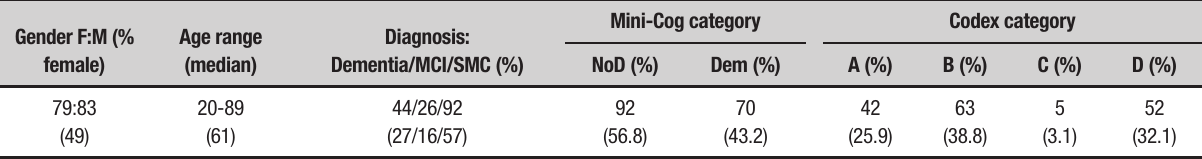
Table 1. Study demographics and base category data.